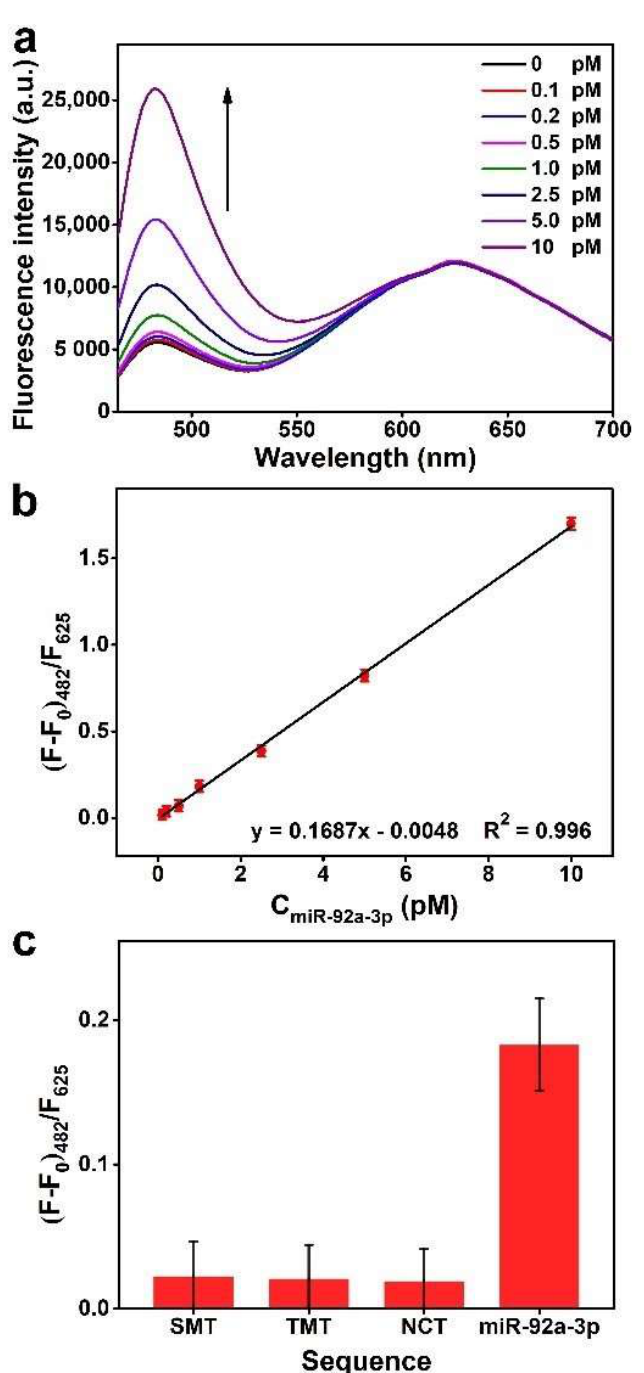
Figure 5. ( a ) Fluorescence spectra of the biosensor under different concentrations of miR-92a-3p. ( b ) The calibration line of the Δprobe/MWCNTs@Au NCs fluorescence ratio against the concentration of miR-92a-3p ( n = 3, mean ± s.d.). ( c ) Comparison of the fluorescence signals produced by miR-92a-3p and mismatched sequences ( n = 3, mean ± s.d.).